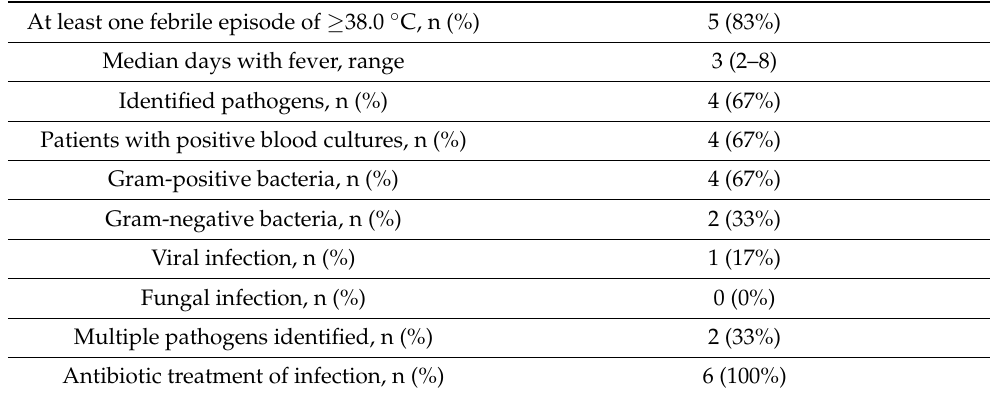
Table 3. Infectious